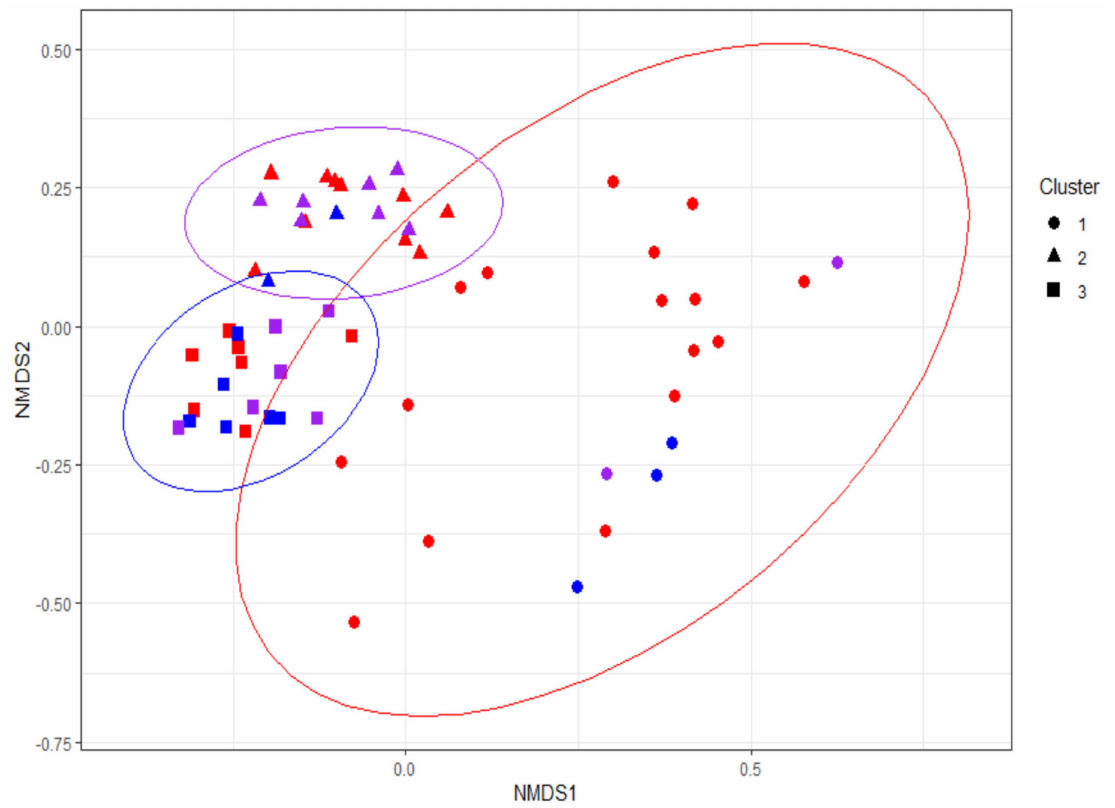
Figure 3. Beta-diversity by infant secretor phenotype. The Bray–Curtis distance between the subjects resulted in significant clustering by infant secretor status by infant phenotype (Adonis p = 0.043). The three clusters generated by the k-means are depicted as triangles, circles, and squares, and the ellipses correspond to the k-means (k = 3) clusters of all points, irrespective of phenotype. A significant asso- ciation of phenotype to these clusters occurred. Thus, at least three distinct enterotypes of microbial communities could be identified and are significantly associated with infant secretor